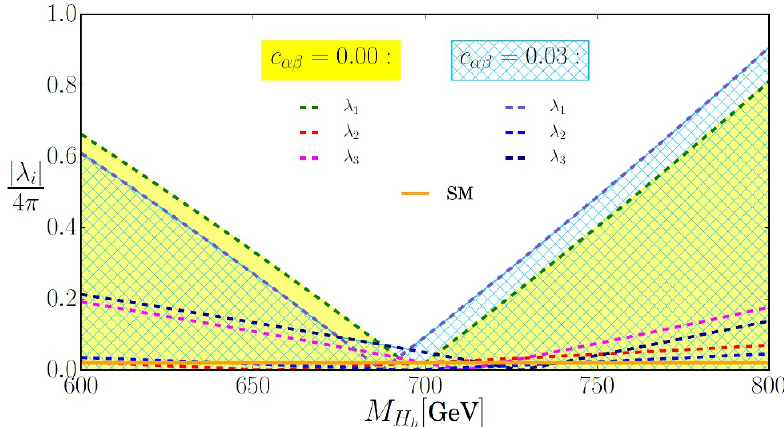
Figure 5 . The range of (cid:21) i = (4 (cid:25) ) for our benchmark scenarios compared to the SM value j j (cid:21) SM = (4 (cid:25) ) = 0 : 02 (solid, orange line). For the two di(cid:11)erent values of c (cid:11)(cid:12) the individual curves for those (cid:21) i = (4 (cid:25) ) that are di(cid:11)erent from zero are also shown (dashed lines). The explicit formulae j j for the parameters (cid:21) i are given in eqs. (B.1){(B.5) of appendix B. The values shown here are for the non-MS schemes and thus no running is taken into